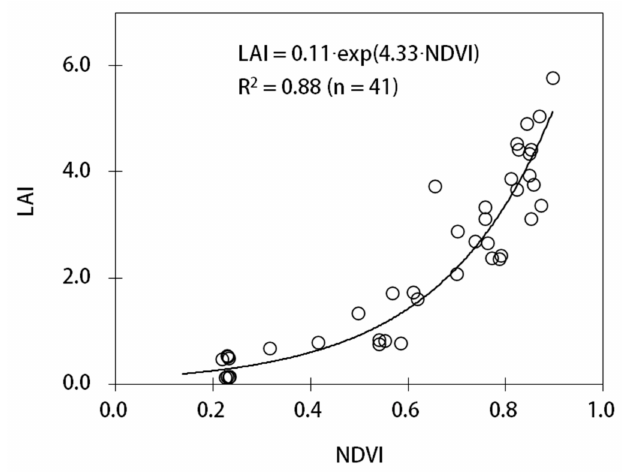
Figure 3. Relationship between leaf area index (LAI) and normalized difference vegetation index (NDVI) using the dataset obtained from the plant stress and water conservation laboratory in Lubbock, Texas, USA, from 2003 to